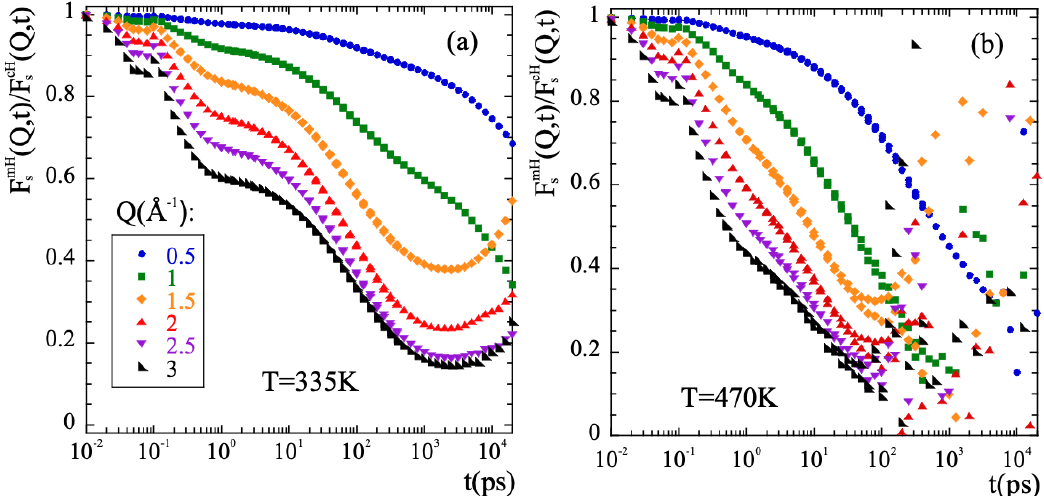
Figure 7. Result of dividing the intermediate scattering functions corresponding to methyl-group hydrogens and main-chain hydrogens at the Q -values indicated in ( a ) for T = 335 K ( a ) and T = 470 K ( b